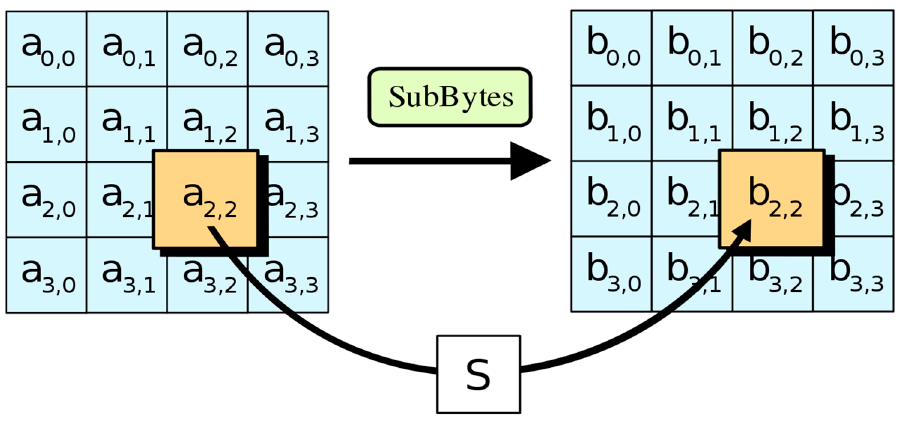
Figure 2. Steps of Sub Bytes.